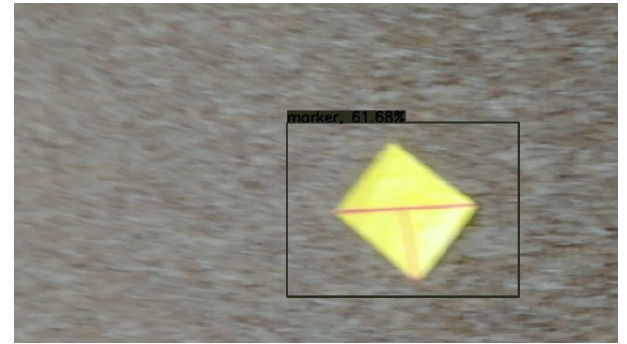
Figure 18. Example of a mild motion blur, the image illustrates how the “T cross” shape